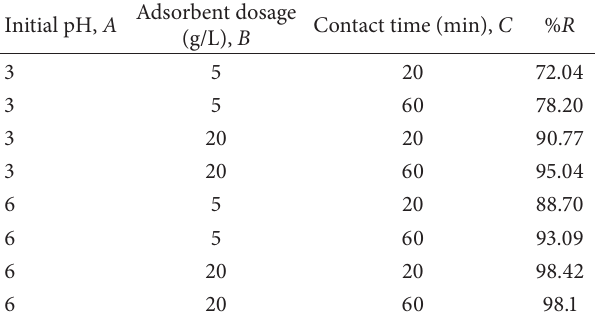
Table 2: Experimental design (2 3 ).